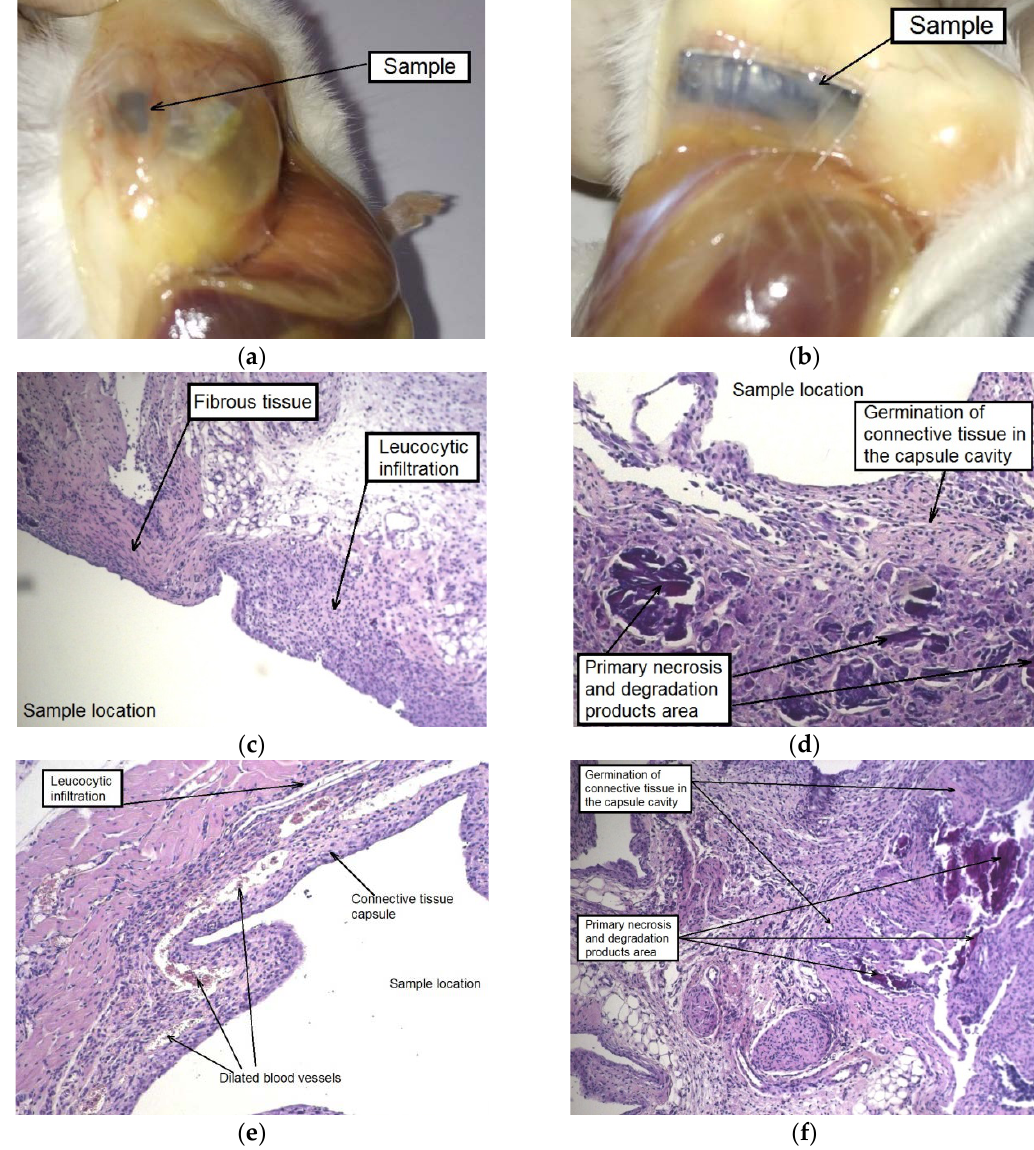
Figure 8. Samples of alloy WE43 and the implantation areas four weeks after surgery: alloy samples in the initial ( a ) and the UFG ( b ) states with the surrounding tissue; result of a histological examination of tissues (HE staining) in the contact area with the alloy in the initial ( c , d ) and the UFG ( e,f ) states.